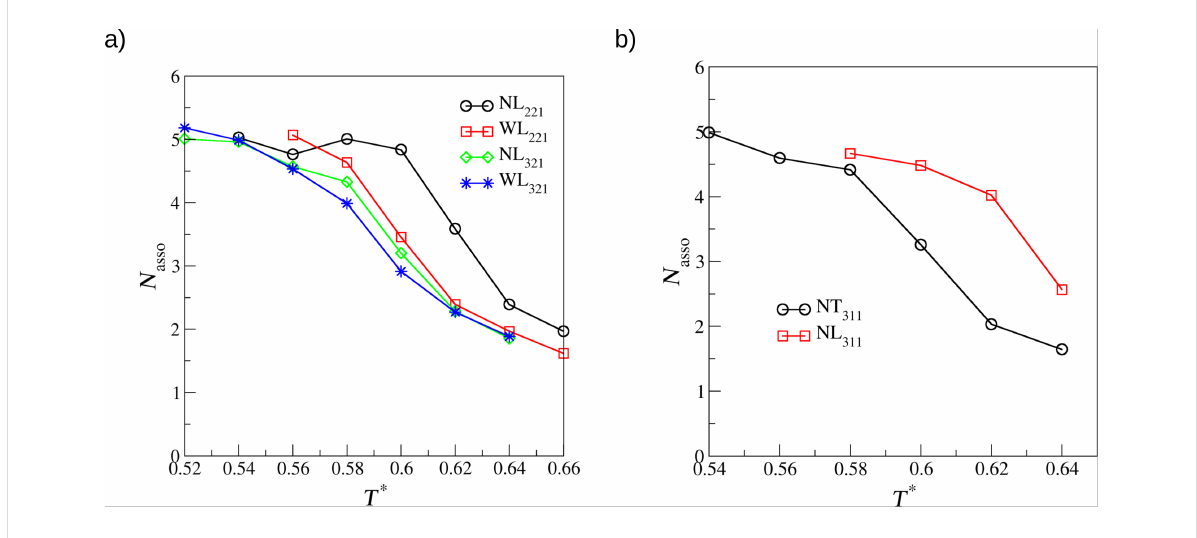
Figure 5: a, b) Average association number, N asso , as a function of the temperature for the molecules given in the legends.